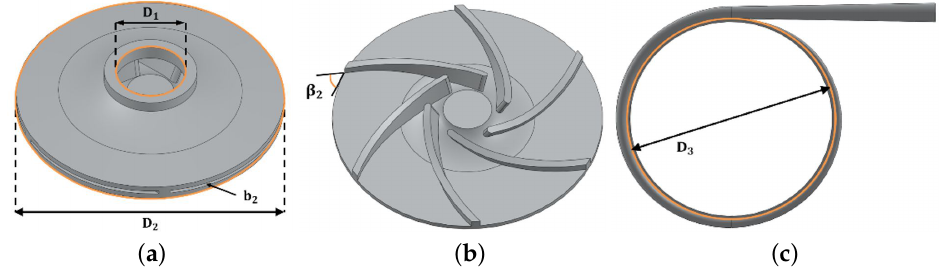
Figure 7. Ultra-low specific speed centrifugal pump configuration: ( a ) impeller; ( b ) blade; ( c ) volute. Table 1. Design parameters of the centrifugal